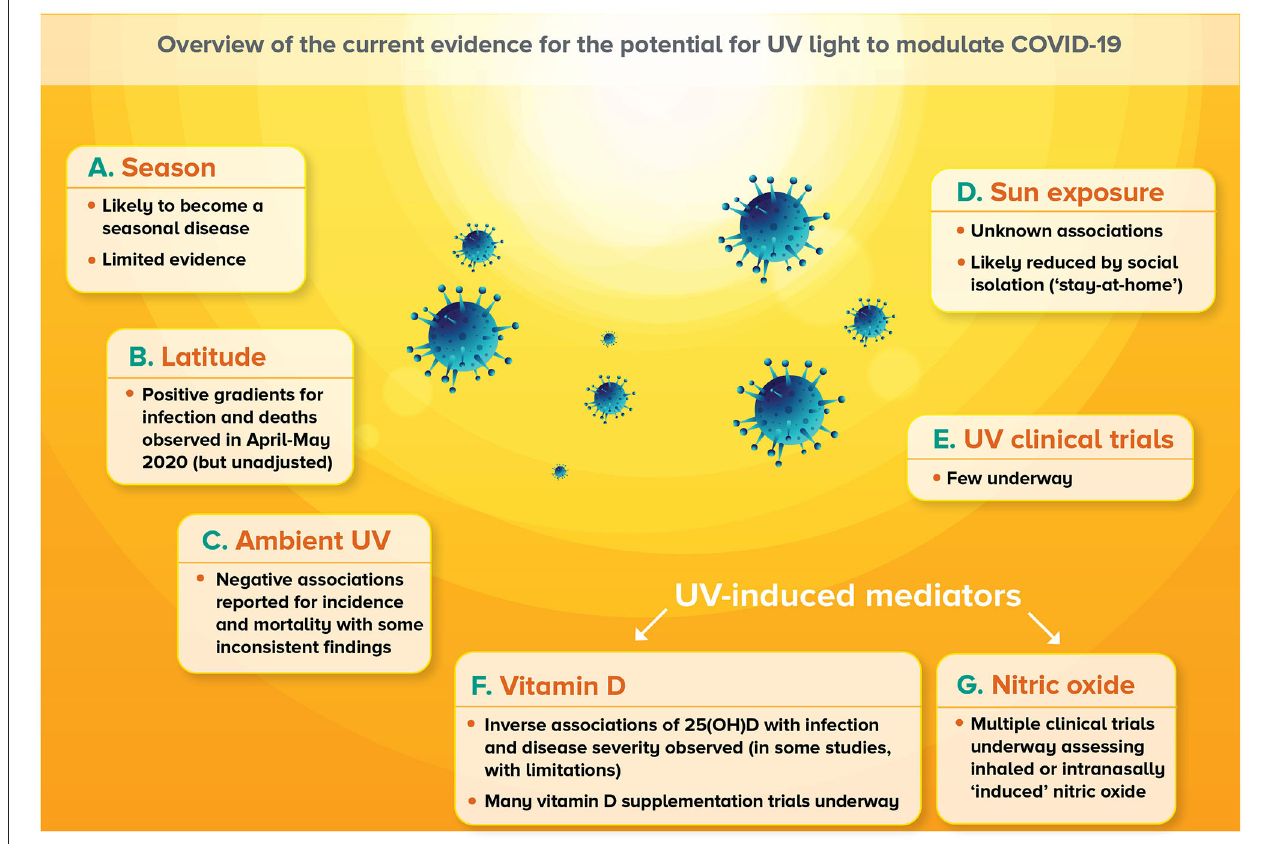
FIGURE 1 | Overview of current evidence for the potential for UV light to modulate COVID-19. (A) Infections with SARS-CoV-2 are predicted to establish seasonality, although there is limited evidence for this as yet. (B) Positive latitude gradients for COVID-19-related outcomes were observed in April–May 2020, although these findings were largely unadjusted for country-wide differences in public health measures as well as other important factors. (C) Negative associations between ambient UVA or UVB levels and COVID-19-related outcomes have been observed with some inconsistent findings, particularly for incidence. (D) Little information has been published around the associations between sun exposure and COVID-19, although it is likely that social isolation (“stay-at-home”) orders implemented by many legislatures limited opportunities for sun exposure. (E) Very few clinical trials are currently underway investigating whether deliberate exposure to UV radiation, or sunlight could affect COVID-19 outcomes. (F) Some emerging evidence suggests inverse correlations between circulating 25-hydroxyvitamin D [25(OH)D] levels with COVID-19 outcomes, although findings are limited in their scope. There are also many clinical trials that are testing the capacity of supplementation with vitamin D to reduce the incidence and severity of COVID-19. (G) A number of clinical trials are also underway assessing the potential for inhaled nitric oxide or nitric oxide intra-nasally generated or released (“induced”) by application of a